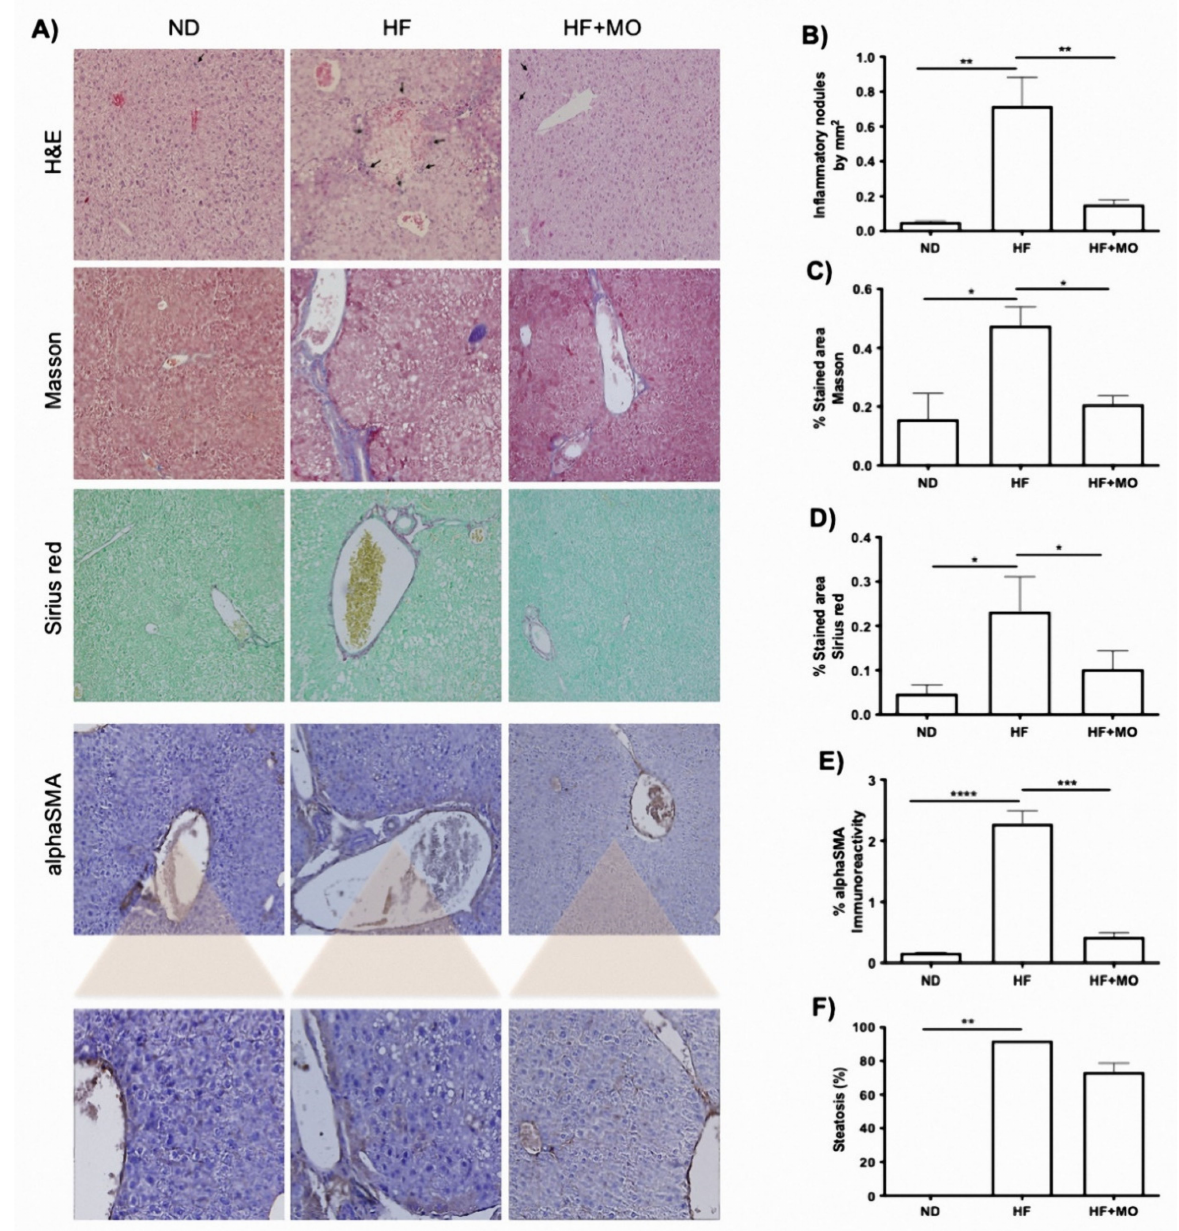
Figure 3. Liver histology showed improved parameters after Mo supplementation. ( A ) Representative microphotographs (40X) of liver tissue stained with H&E, Masson, Sirius Red and after IHQ against α SMA. ( B ) Quantity of inflammatory nodules is reduced in Mo animals compared to HF group ( p < 0.01). ( C , D ) showed a decrease in ECM and collagens after Mo supplementation ( p < 0.05). ( E ) Positivity to α SMA is increased only in HF animals ( p < 0.001). ( F ) steatosis tent to be reduced in Mo animals. Data are expressed as mean ± SE. * p < 0.05; ** p < 0.01; *** p < 0.001; **** p <